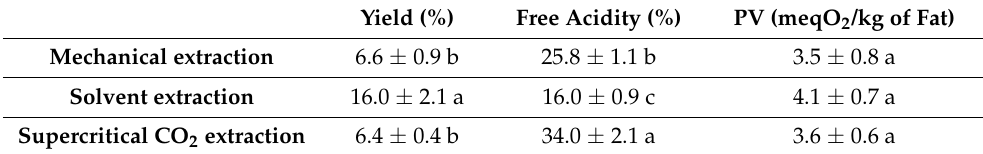
Table 2. Yield (dry basis), free acidity and peroxide value of WGO extracted with different technologies. Yield (%) Free Acidity (%) PV (meqO 2 /kg of Fat) Mechanical